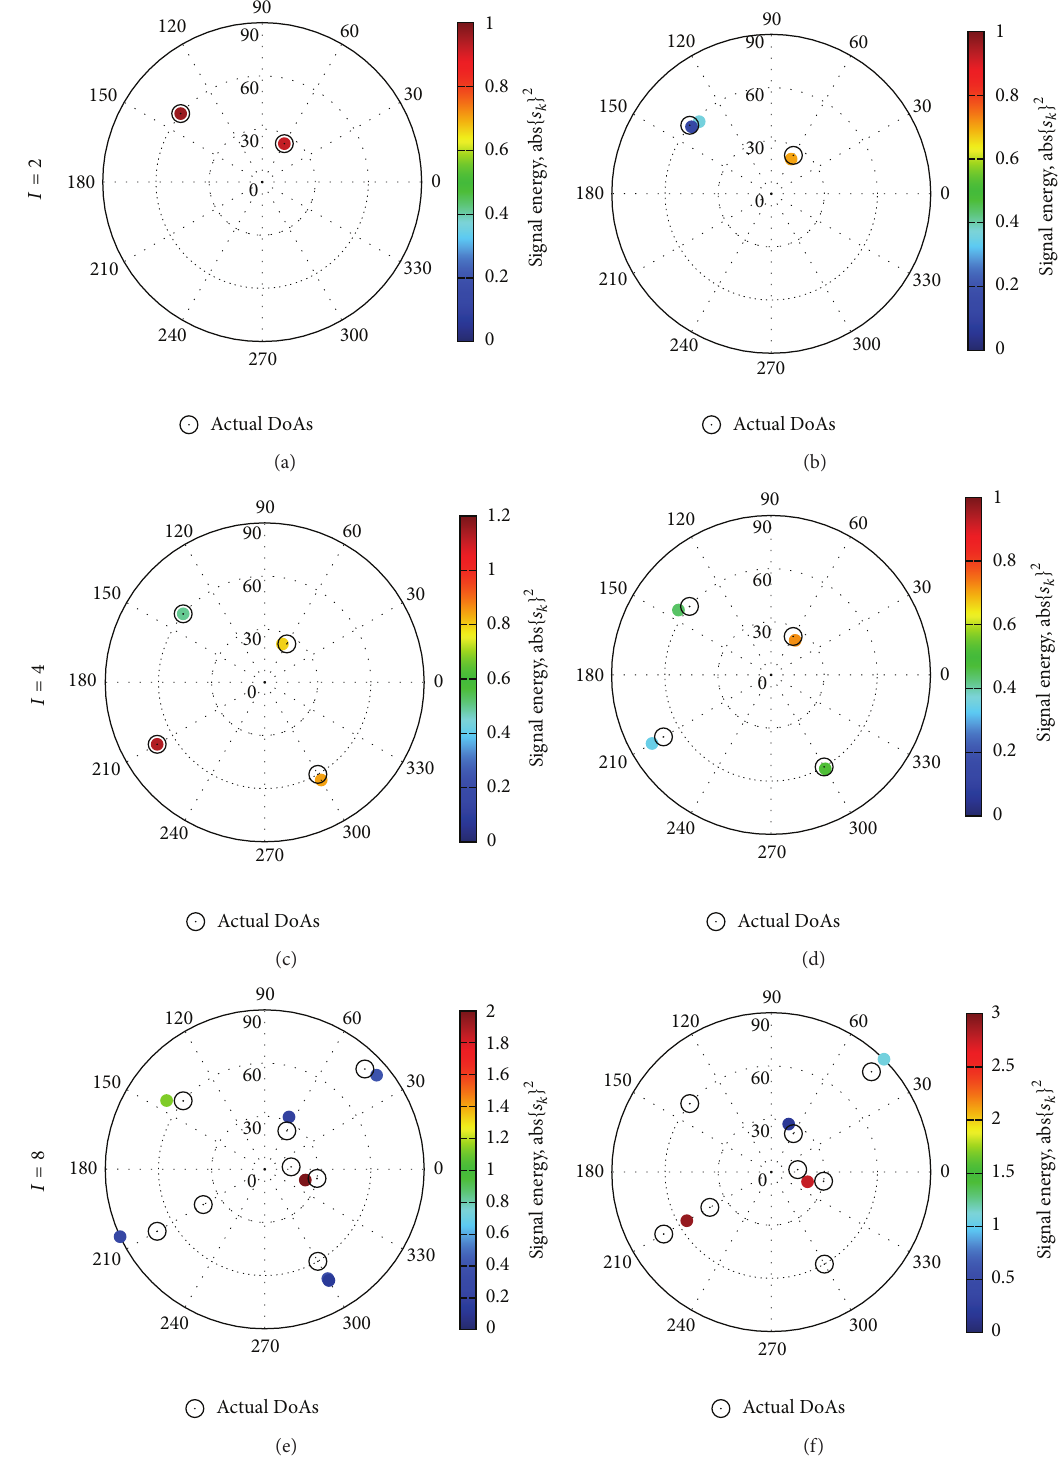
Figure 3: Fully populated array—( 𝑁 = 25 ; 𝑑 𝑥 = 𝑑 𝑦 = 0.5𝜆 ; 𝐼 ∈ [2 : 8] ; SNR = 10dB; 𝑇 = 1 ; 𝐶 = 50 )—plot of the best (left column) and worst (right column) estimations obtained by means of the ST-BCS among the 𝐶 different noisy scenarios when (a) (b) 𝐼 = 2 , (c) (d) 𝐼 = 4 , and (e) (f) 𝐼 = 8